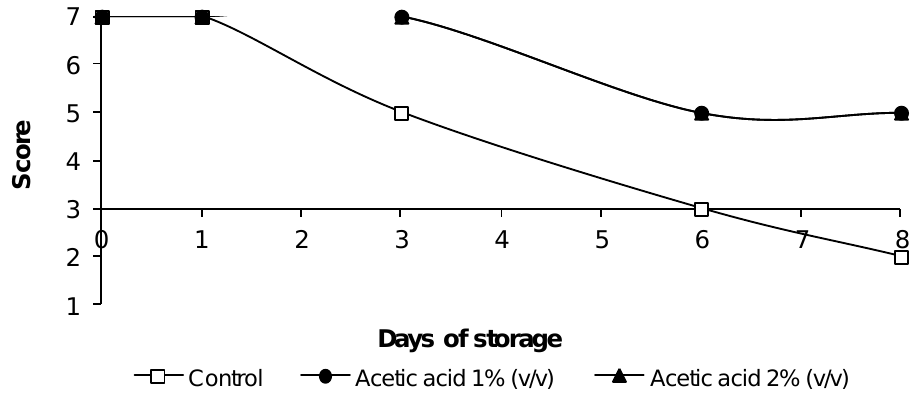
Figure 3. Evolution of odor in chicken legs treated with acetic acid. The data are the mean values of six